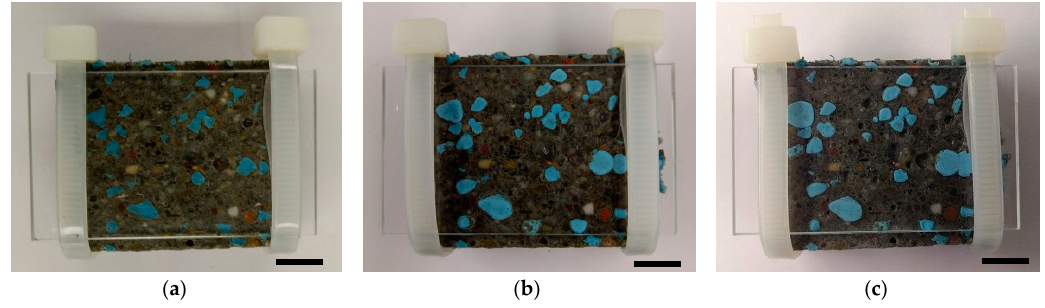
Figure 5. Swelling effect of WSRPs in a simulated crack with a crack width of 0.8 mm at ( a ) 0 day; ( b ) 3 days and ( c ) 7 days of the specimens being immersed in water. The length of scale bar in images is 10 mm.